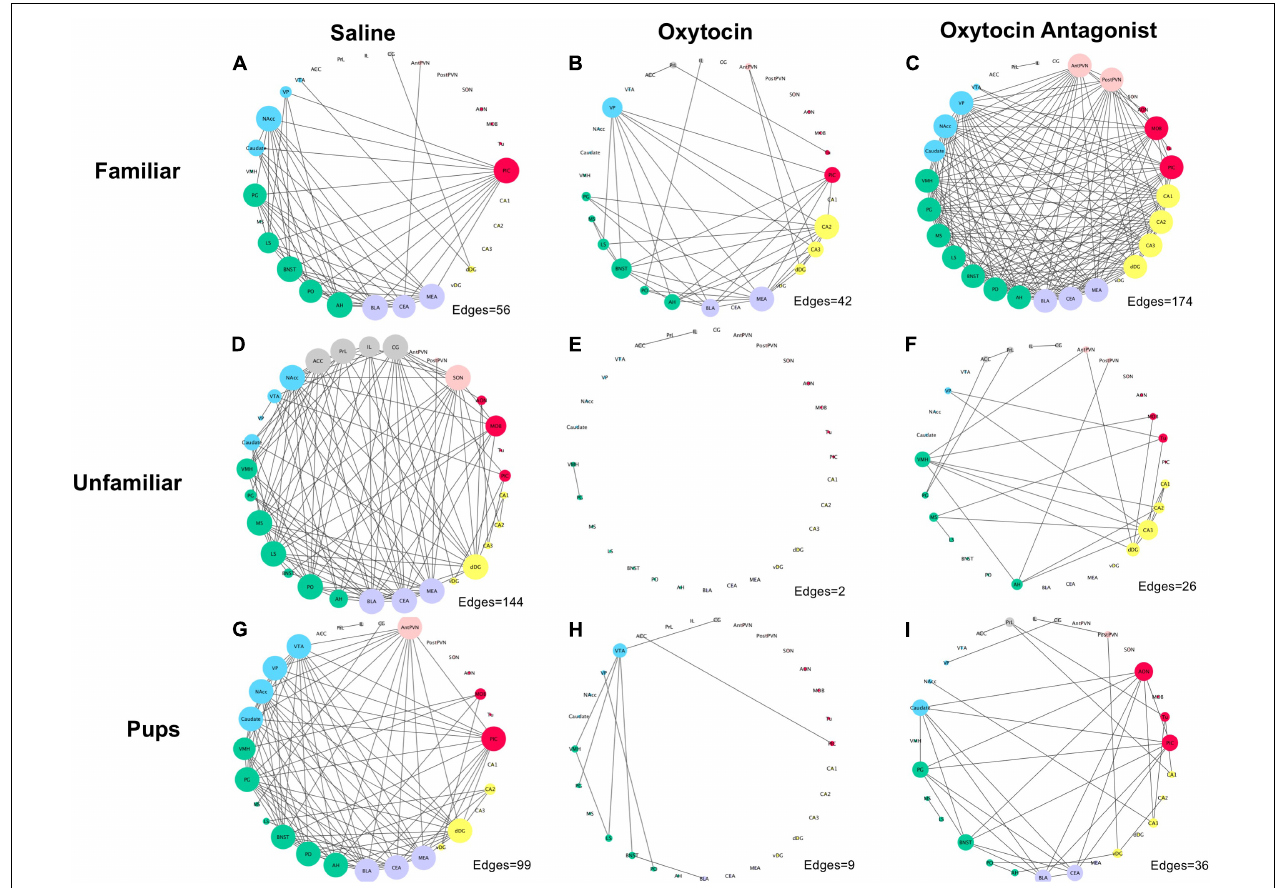
FIGURE 5 | Correlation networks separated by behavioral paradigm and OT manipulation. Pair-wise Pearson correlations were calculated for c-Fos cell counts with multiple-testing corrected for using the Benjamini–Hochberg method with a false discovery rate of 5%. Brain regions are color-coded based on anatomically and functionally similar groups (blue, reward; green, social behavior network; purple, amygdala; yellow, hippocampus; red, olfactory; pink, OT production cluster; and gray, medial prefrontal cortex). Node size is a measure of degree (how many edges are connected to a given node). (A) Saline-treated FAM, (B) OT-treated FAM, (C) OTA-treated FAM, (D) saline-treated UNFAM, (E) OT-treated UNFAM, (F) OTA-treated UNFAM, (G) saline-treated PUP, (H) OT-treated PUP, and (I) OTA-treated PUP. AON, anterior olfactory nucleus; MOB, main olfactory bulb; Tu, olfactory tubercle; PIC, piriform cortex; ACC, anterior cingulate cortex; PrL, pre-limbic cortex; IL, infralimbic cortex; CG, cingulate cortex; PO, pre-optic area; AH, anterior hypothalamus; VMH, ventromedial hypothalamus; PG, periaqueductal gray; BNST, bed nucleus of the stria terminalis; LS, lateral septum; MS, medial septum; AntPVN, anterior paraventricular nucleus; PostPVN, posterior paraventricular nucleus; SON, supraoptic nucleus; MeA, medial amygdala; BLA, basolateral amygdala; CeA, central amygdala; Caudate, caudate putamen; VP, ventral pallidum; NAcc, nucleus accumbens; VTA, ventral tegmental area; CA1, cornu ammonis 1; CA2, cornu ammonis 2; CA3, cornu ammonis 3; dDG, dorsal dentate gyrus; vDG, ventral dentate